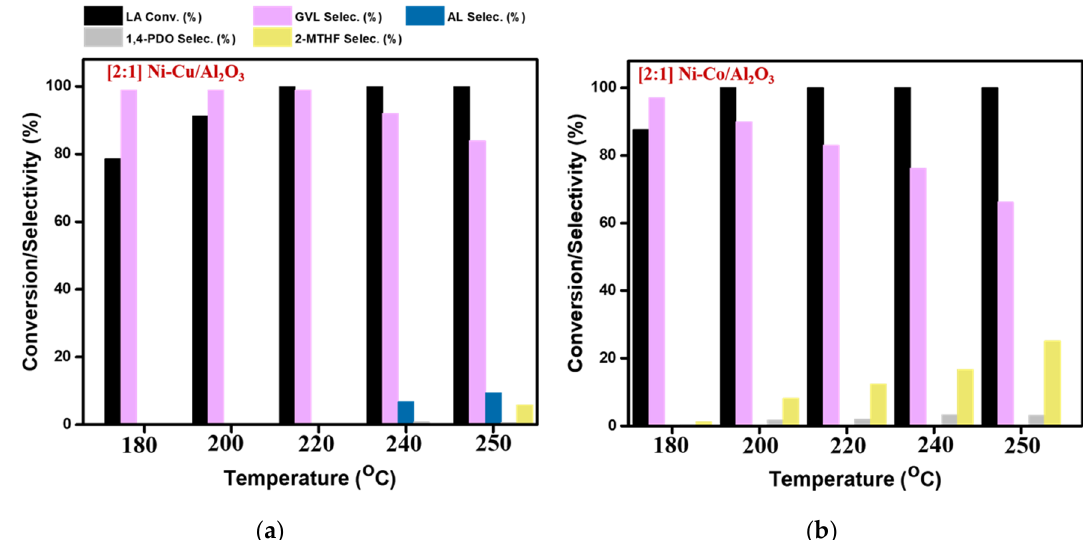
Figure 9. Reaction results for the effect of reaction temperature over ( a ) [2:1] Ni-Cu/Al 2 O 3 and ( b ) [2:1] Ni-Co/Al 2 O 3 on the hydrogenation of LA. Reaction conditions: 20 mL LA, 1 g catalyst, 30 bar H 2 pressure and 6 h reaction time.